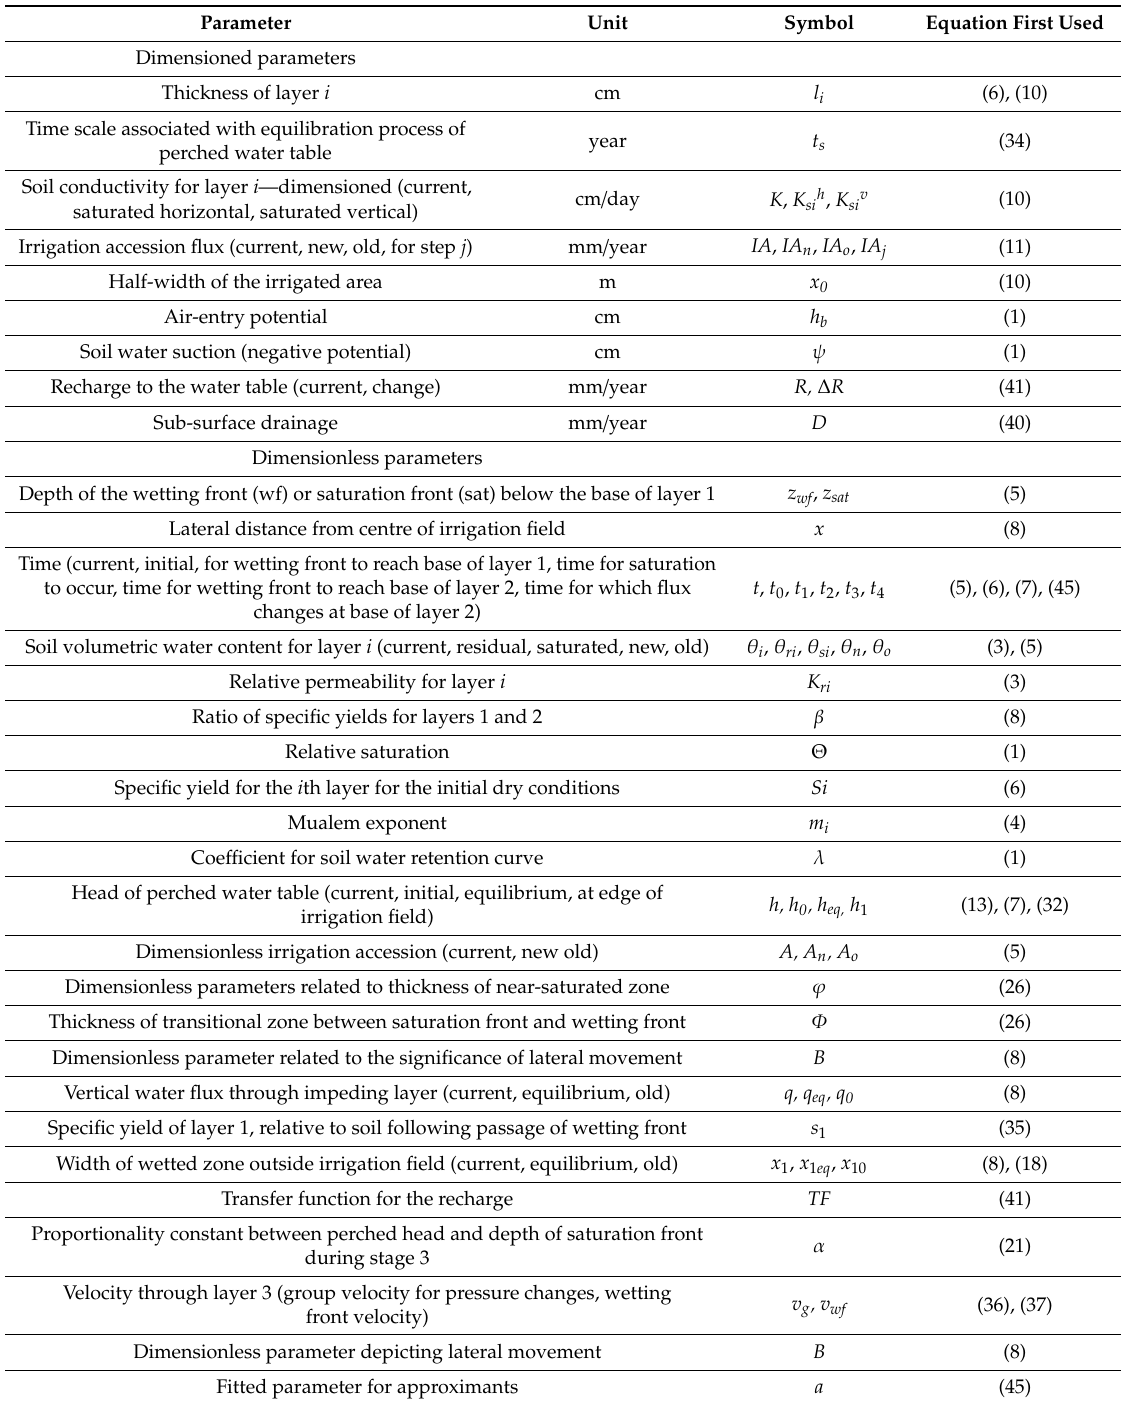
Table 1. Glossary of parameters, symbols and units used in equations and the equation number, where first